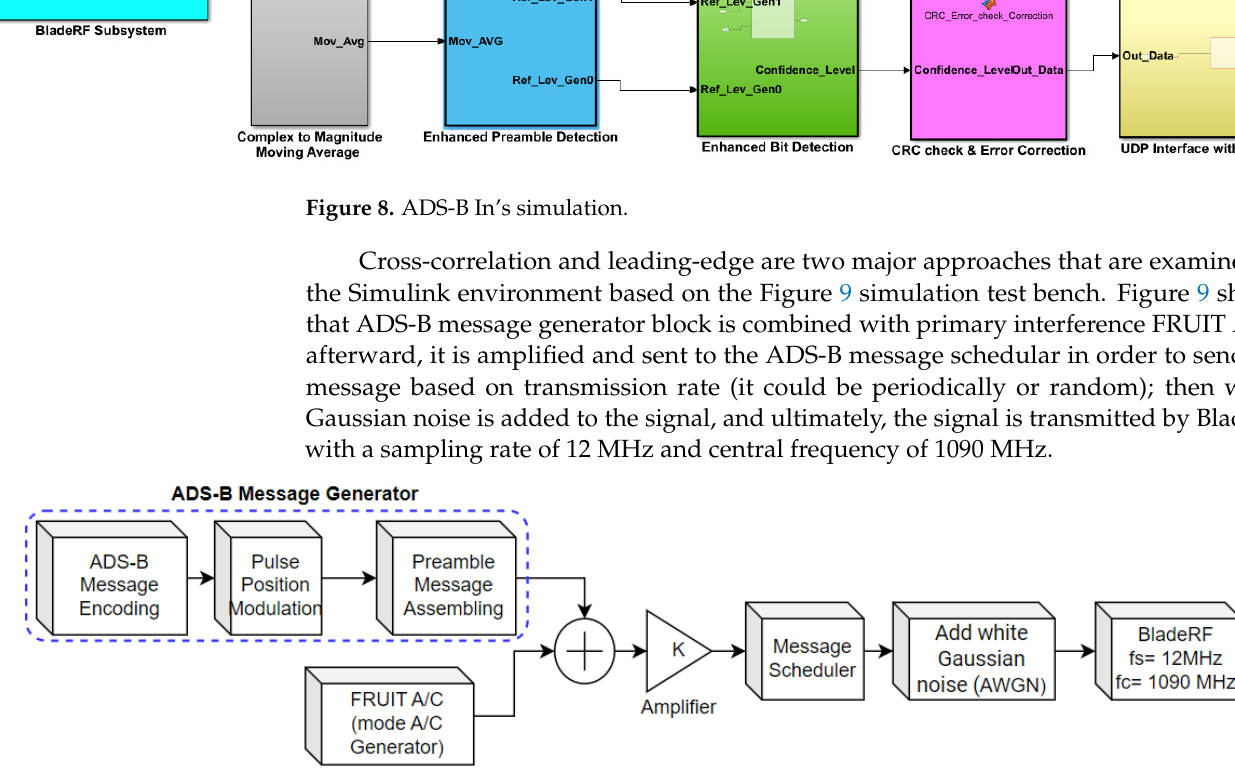
Figure 9. Simulation test bench for ADS-B In performance evaluations.